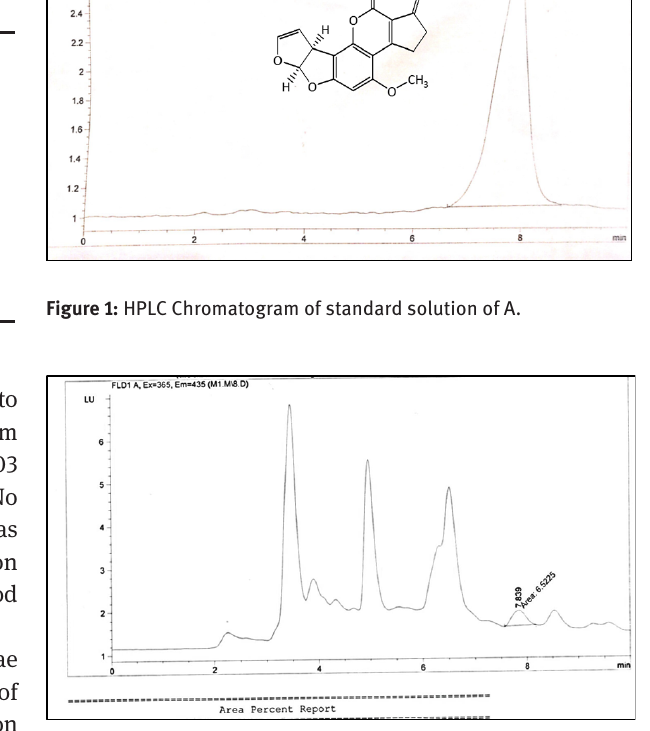
Table 2: Level of AFM1 in different types of Milk based Mithae. Sample Type